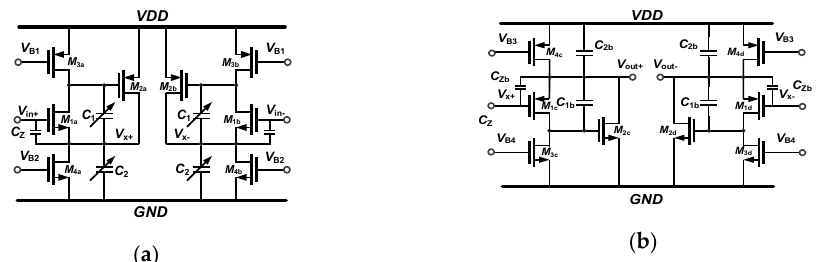
Figure 3. Schematics of the ( a ) first biquadratic low-pass filter and ( b ) second biquadratic low-pass filter of the low-pass filter (LPF).